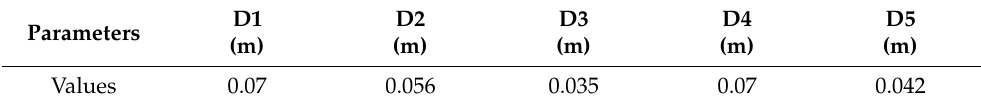
Table 2. Diameters of the shafts.